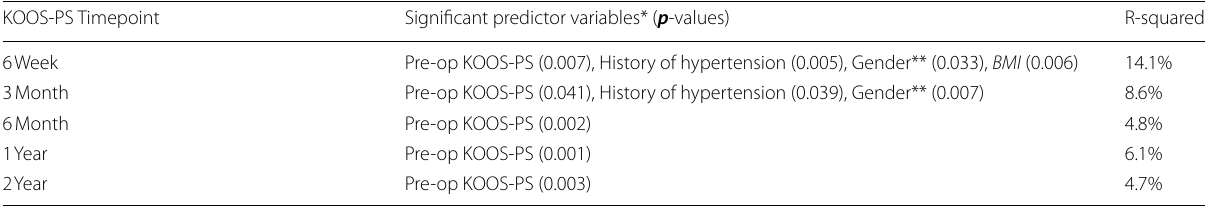
*Italics indicates negative correlation **Men showed slightly higher KOOS-PS at 6 Weeks and 3 Months